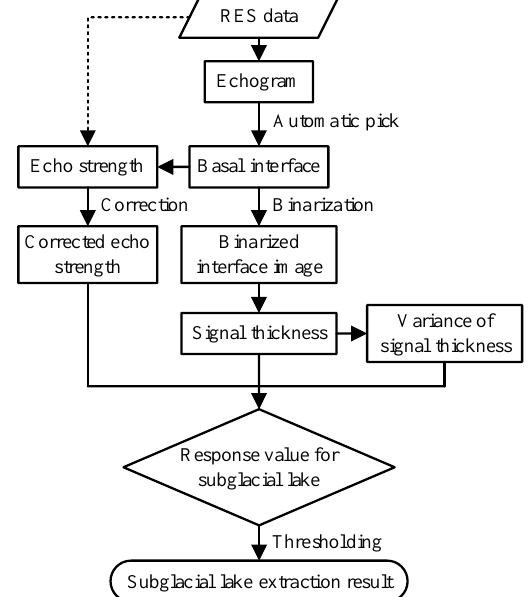
Figure 3 . Block scheme of proposed method.